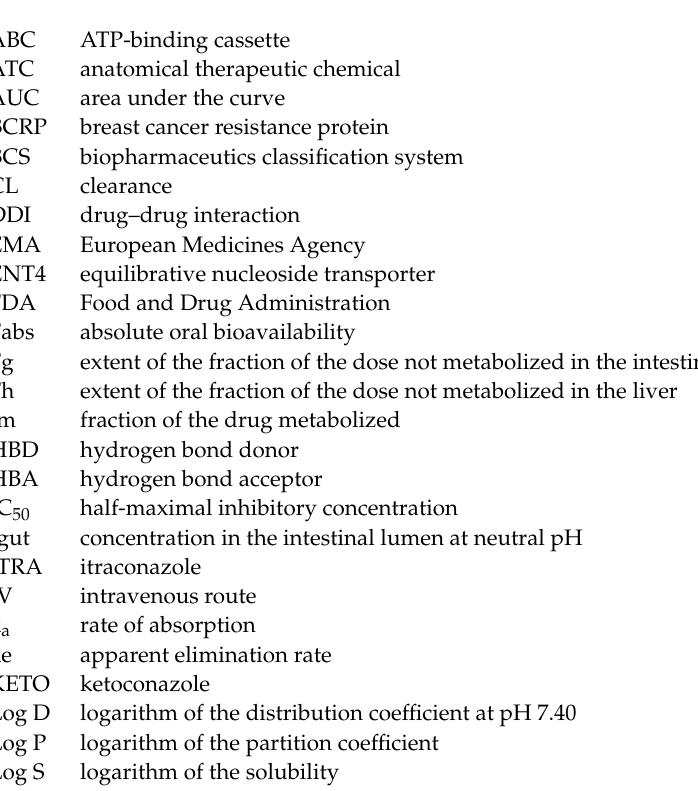
Figure S2. Distribution of the solubility at neutral pH classified according to the USP classification in a series of oral targeted anticancer drugs. Figure S3. Variations in MAT ratio following ± 10% variations in t max in a series of oral targeted anticancer drugs. Table S1. Pharmacologic class